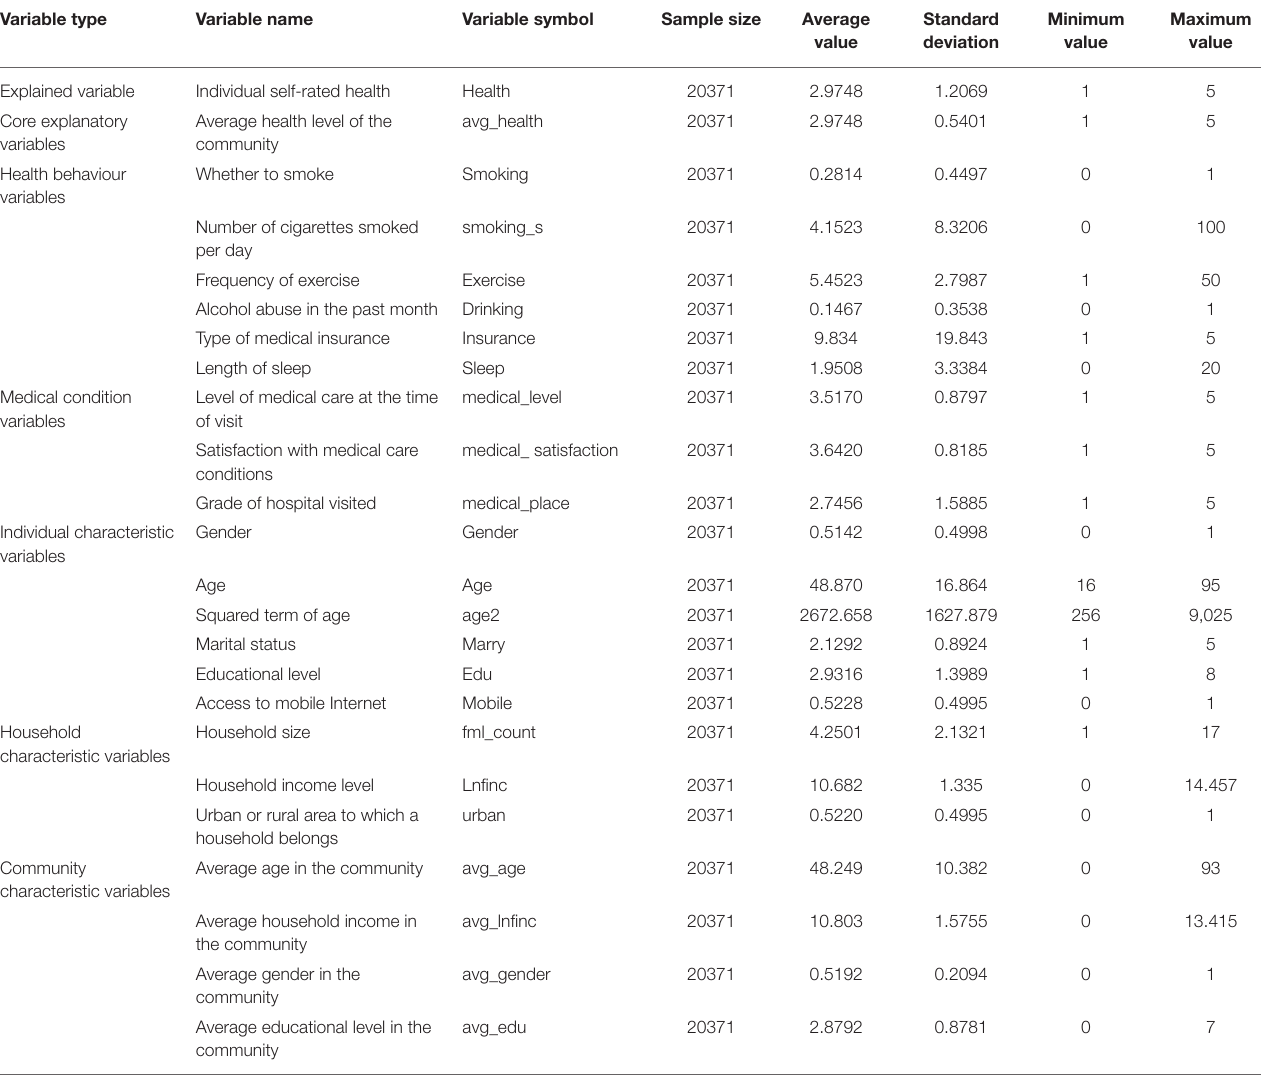
TABLE 1 | Definition and descriptive statistics of